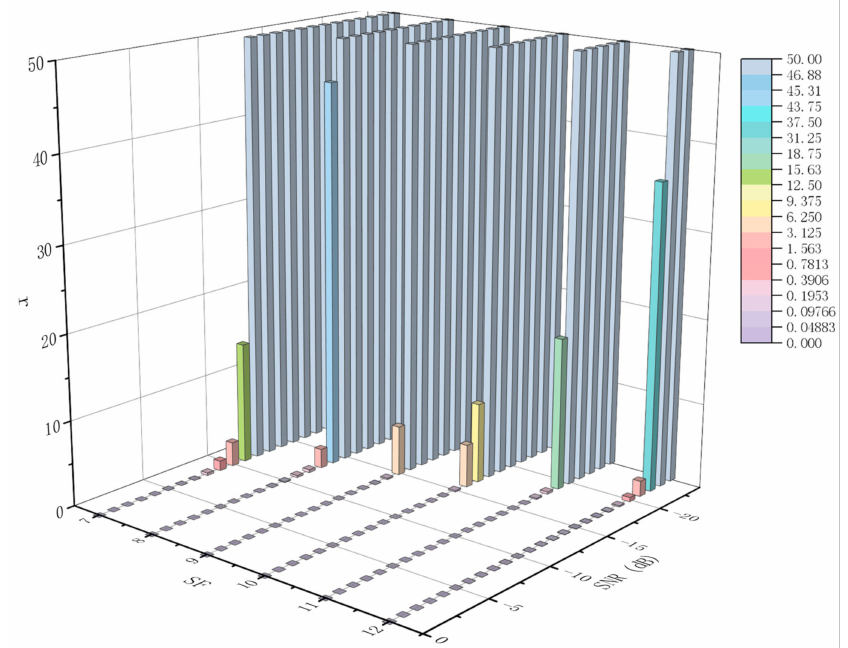
Figure 11. The number of packet retransmissions for different Signal to Noise Ratio (SNR) and SF